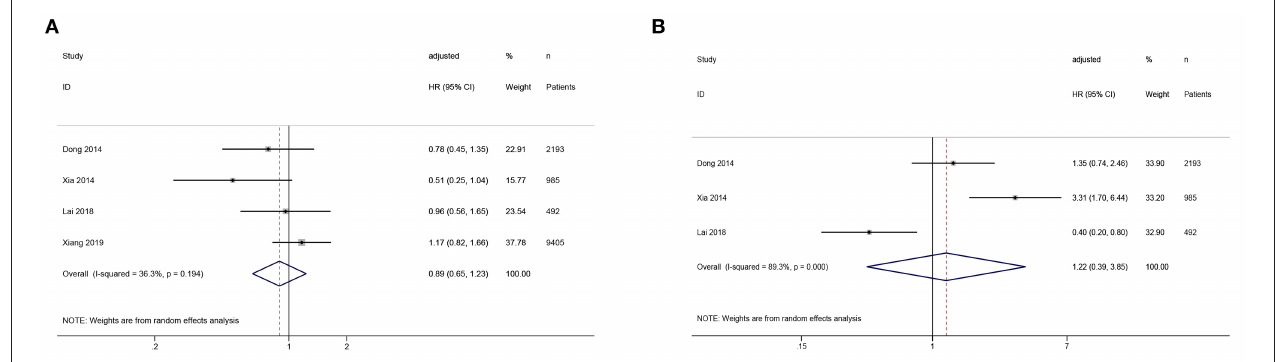
FIGURE 3 | Forest plot of the association between serum uric acid levels and cardiovascular mortality in PD patients. (A) low vs. middle; (B) high vs. low.